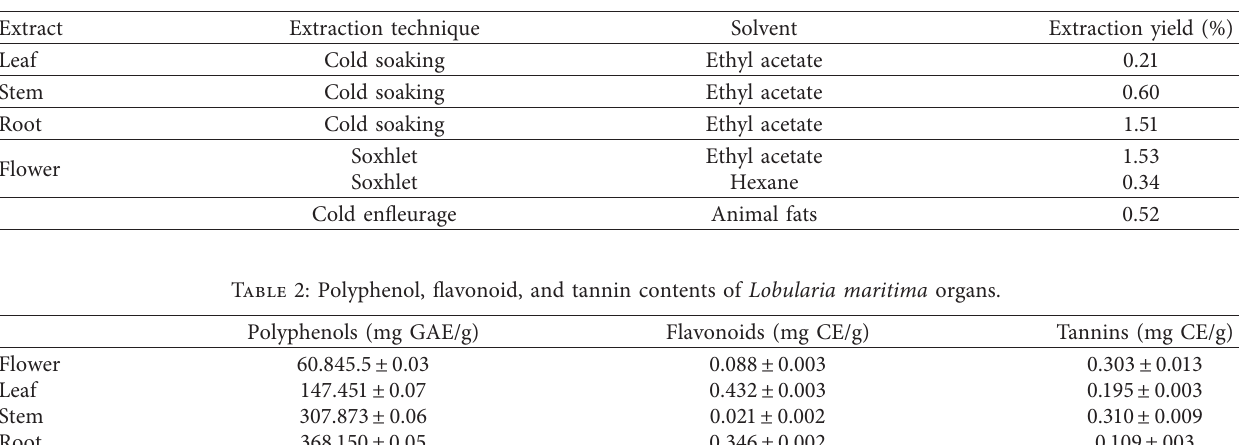
Table 3: Antiradical efficiency EC